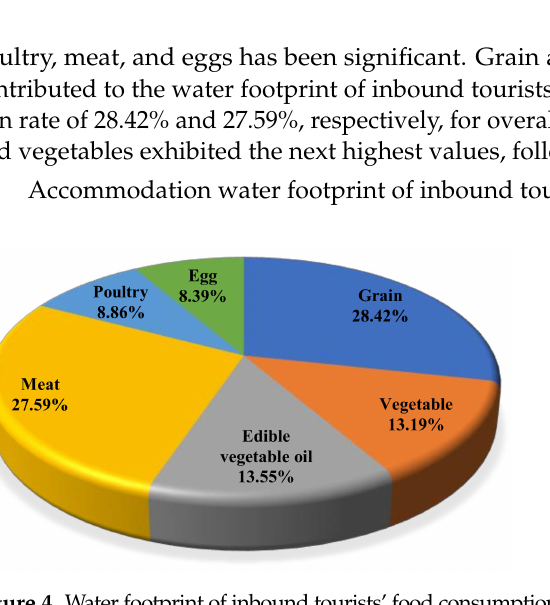
Figure 4. Water footprint of inbound tourists’ food consumption (according to food consumption